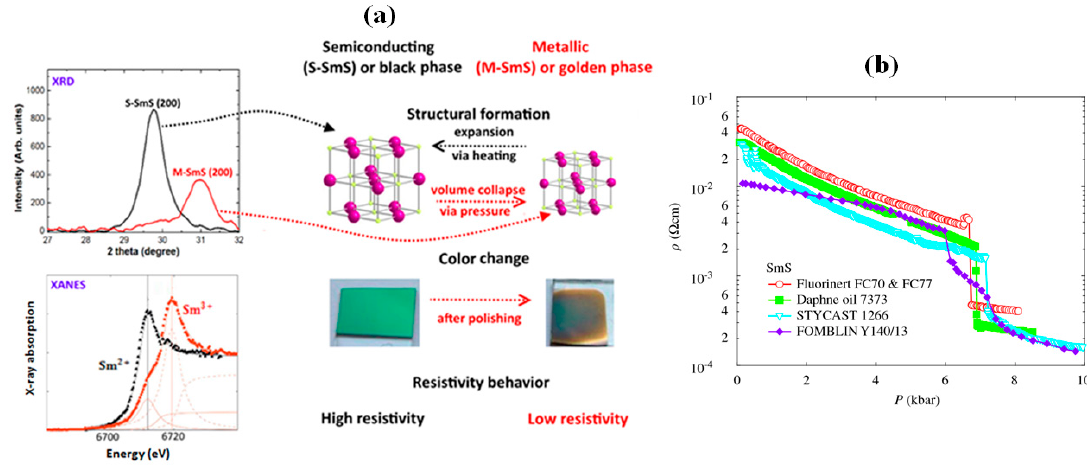
Figure 1. ( a ) Basic properties of SmS. The XRD pattern (upper left) demonstrates the shift of the (200) diffraction peak, when S-SmS (semiconducting, black curve) switches to M-SmS (metallic). The lower left graph shows the corresponding valence change, as evident from a XANES measurement. In the S-SmS or black state the material shows a NaCl structure with a black-blue color and a high resistivity. The M-SmS or golden state has the same structure with a volume collapse. The color changes to gold and the resistivity drops up to four orders of magnitude. For the unit cell of SmS: purple spheres, Sm; yellow spheres, S. ( b ) Resistivity drop of SmS single crystal. Four different pressure transmitting media are indicated in the graph. (Reprinted with permission from [26], [27] and [24], respectively.)